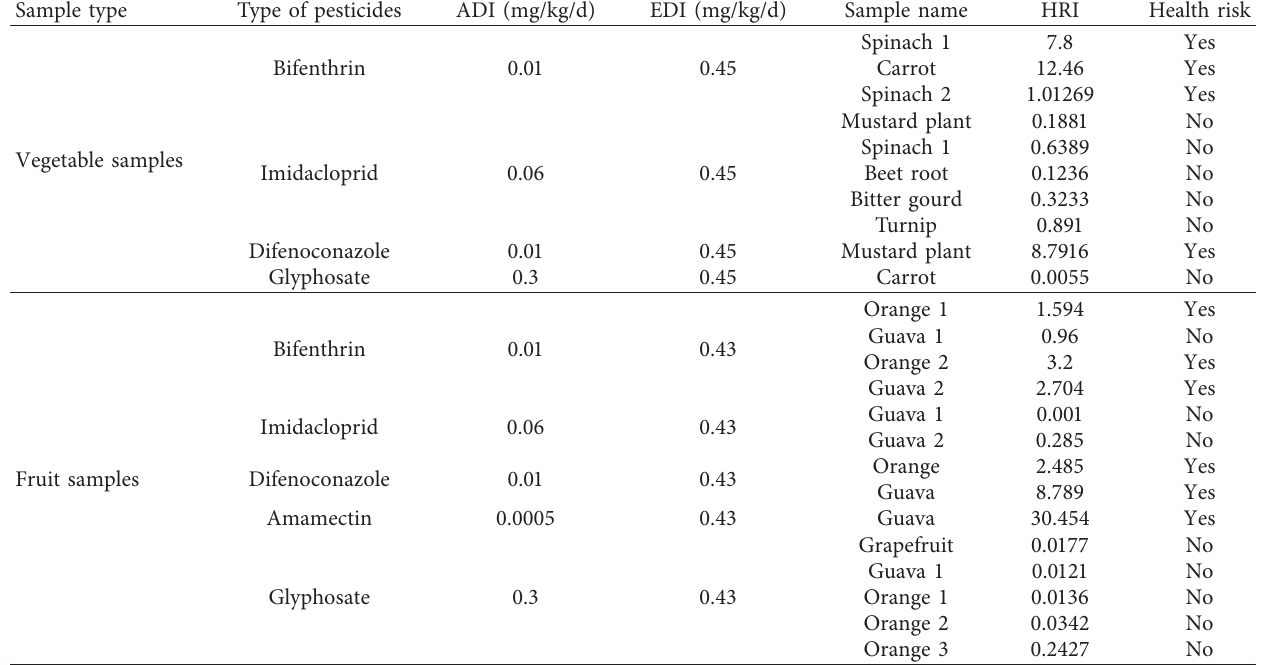
Table 2: Health risk assessment of pesticide residues in sample fruits and vegetables. Sample